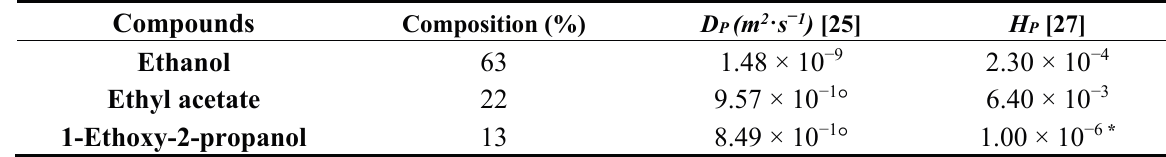
Table 4. VOC composition and physical properties of the compounds of the industrial emission. Compounds Composition